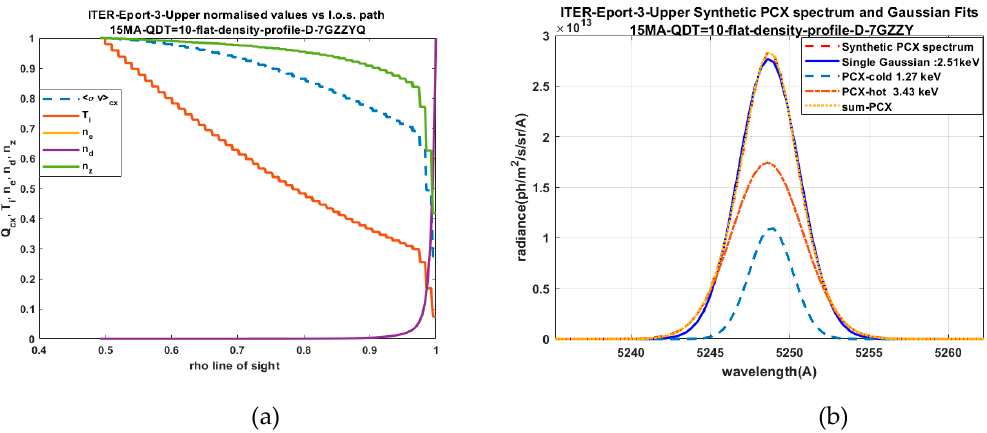
Figure 6. ( a ) Schematic presentation of passive charge-exchange (PCX) model showing normalized radial profiles for neutral density (EIRENE) n d , impurity ion density n z , electron density n e , ion temperature T i and CX emission rates Q CX = < σ v > CX . Note, for ITER, a flat concentration profile is assumed, hence the normalized radial shapes for n z and n e are the same; ( b ) Synthetic line-of-sight integrated NeX PCX spectrum. The non-Gaussian asymmetric shape can be approximated either by a sum of a “cold” (1.14 keV) and “hot” (3.46 keV) component, or, alternatively by a Single Gaussian shape and associated Doppler width and ion temperature (2.4 keV). This temperature corresponds to emission layer located at ρ = 0.98 (Figure 1b).